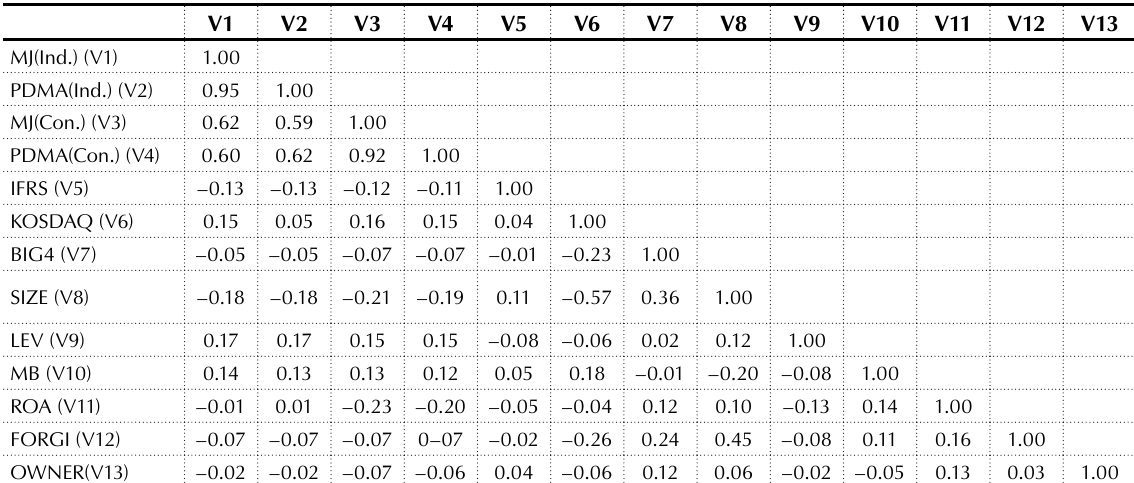
Table 2. Pearson correlation matrix (n =